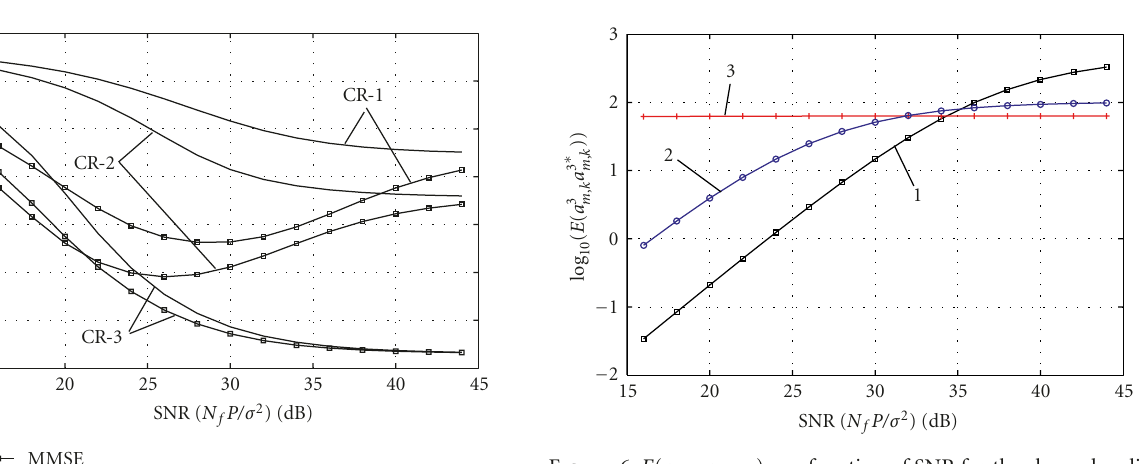
Figure 6: E ( a m , k 3 a m , k 3 ∗ ) as a function of SNR for the channel reali- zation CR-1 given in Table 1 ( N f = 64, RFO = 0.05, plot marked 1-weakest bin, plot marked 2-next weakest bin, plot marked 3- strongest bin. Symbols are from 4-QAM constellation with P =